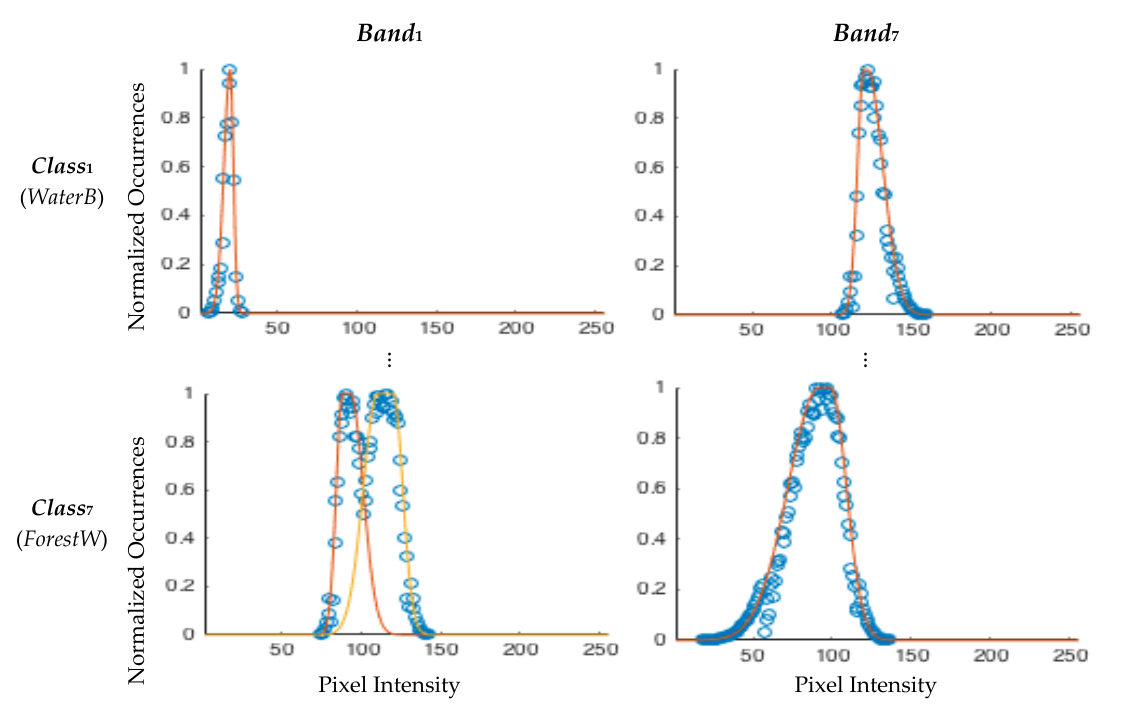
Figure 2. Example of histograms and unimodal and bimodal membership function fits for classes Waterbodies and Forests and Woodlands.